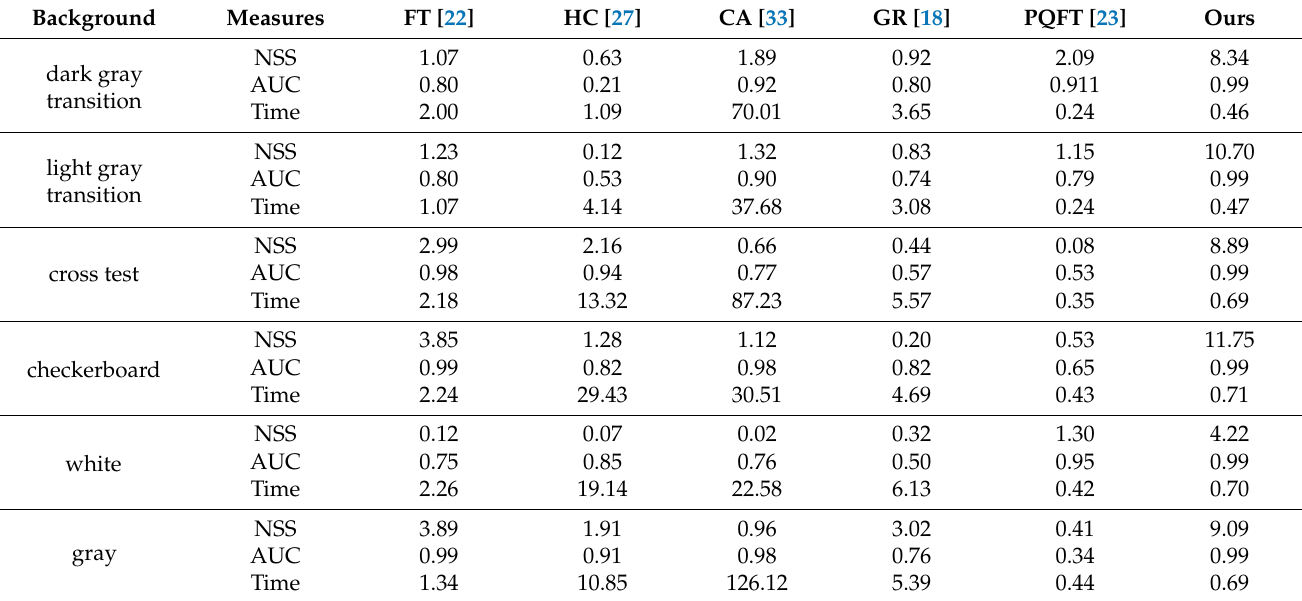
Table 2. Performance comparison of different saliency